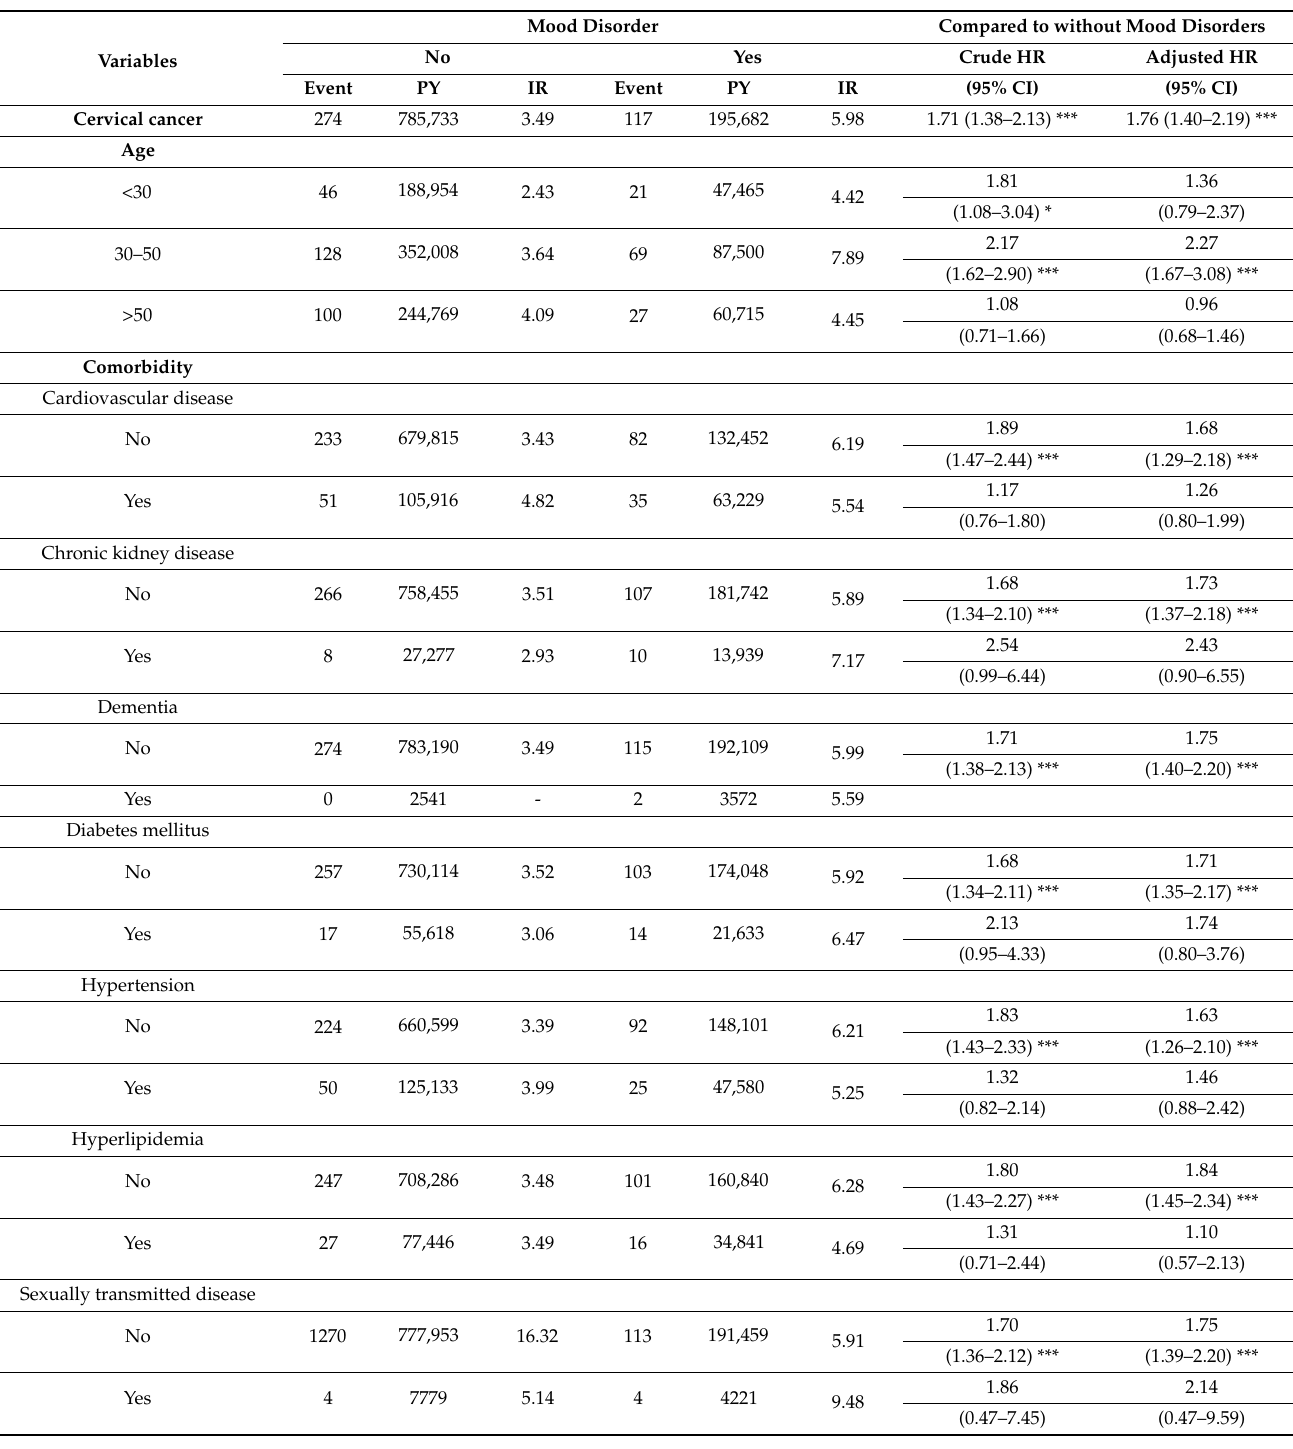
Table 3. Incidence and hazard ratio of cervical cancer stratified by age and other covariates between patients with and without mood